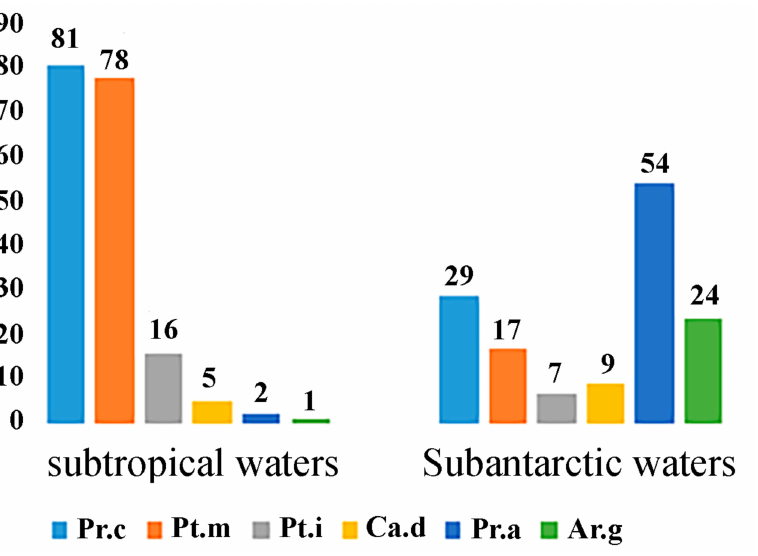
Figure 14. The Procellariidae family in the region of rings. Note: Pr.c is the spectacled petrel Procellaria conspicillata , Pt.m is the soft-plumaged petrel Pterodroma mollis , Pt.i is the Atlantic petrel Pterodroma incerta , Ca.d is Cory’s shearwater Calonectris diomedea , Pr.a is the white-chinned petrel Procellaria aequinoctialis , Ar.g is the great shearwater Ardenna gravis